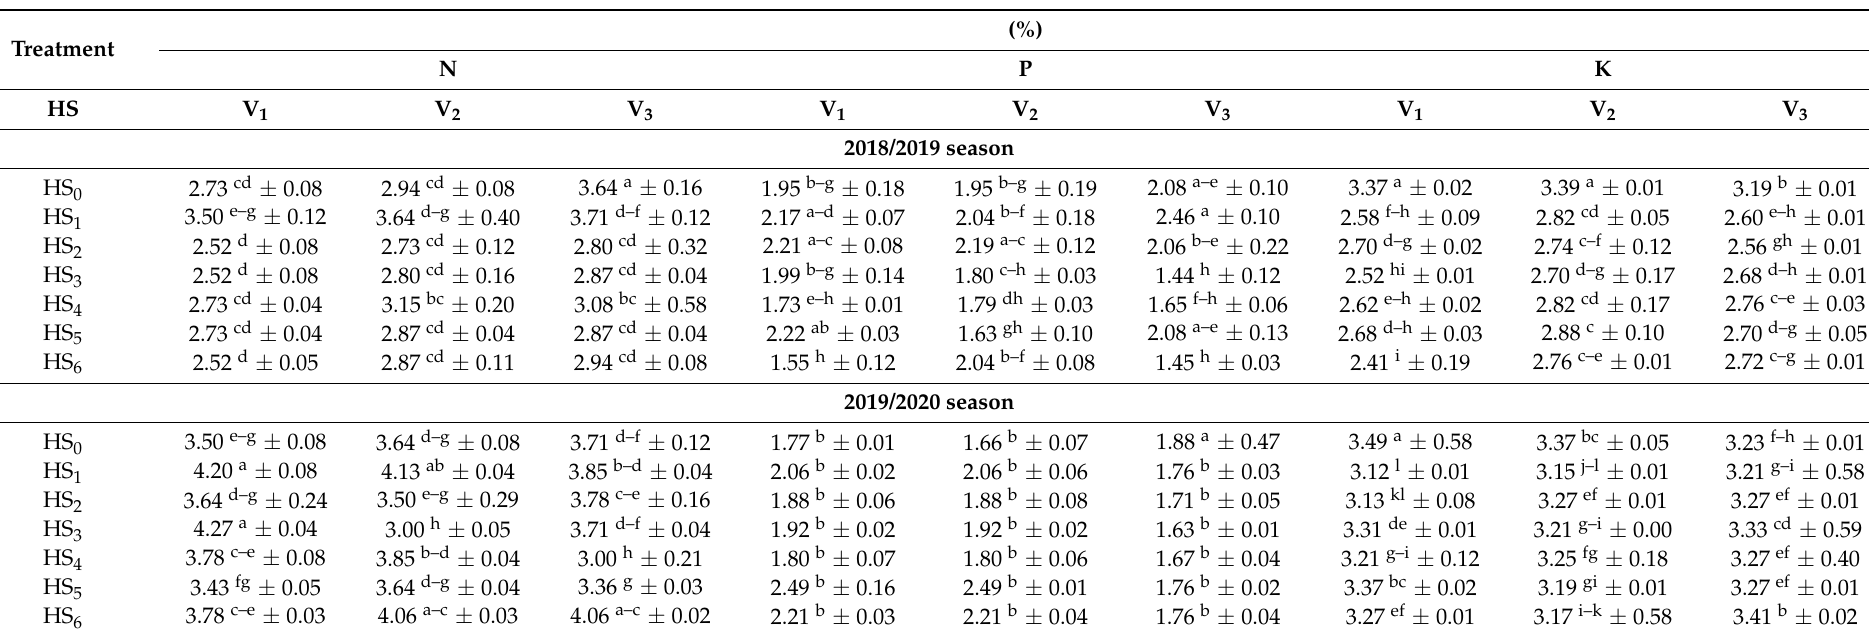
Table 8. Influence of humic substances doses on some leaf nitrogen, phosphorus and potassium contents of some wheat varieties grown in clay soil in 2018/2019 and 2019/2020